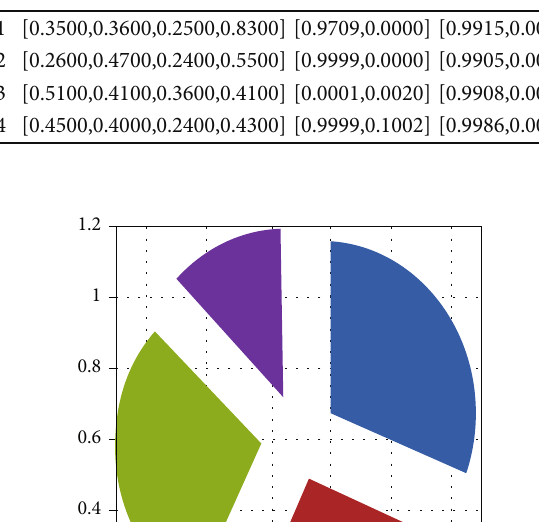
Table 10: Collective